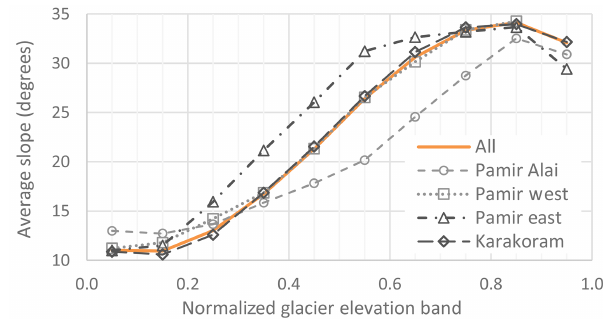
Figure 10. Glacier slope along 10 glacier elevation sections. The glaciers were normalized for elevation to compare high- and low- elevation